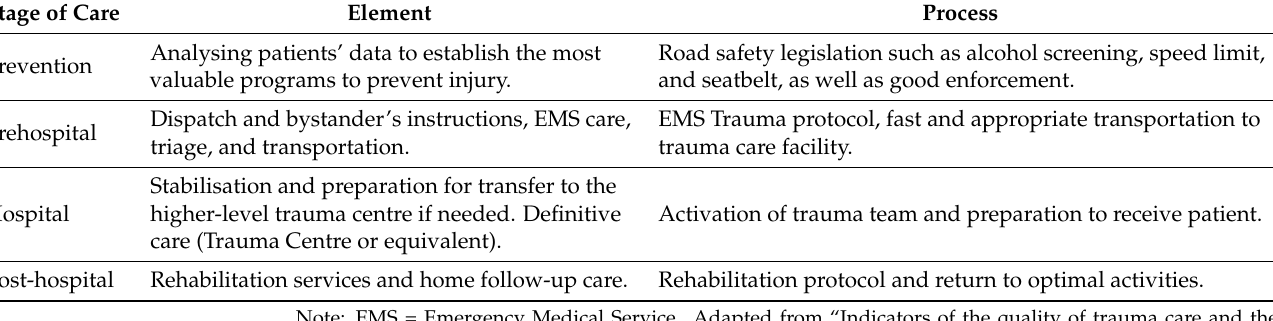
Figure 1. Summary of a trauma patient’s journey from injury to disability or recovery if death does not occur. Table 1. Shows the main phases of trauma care.